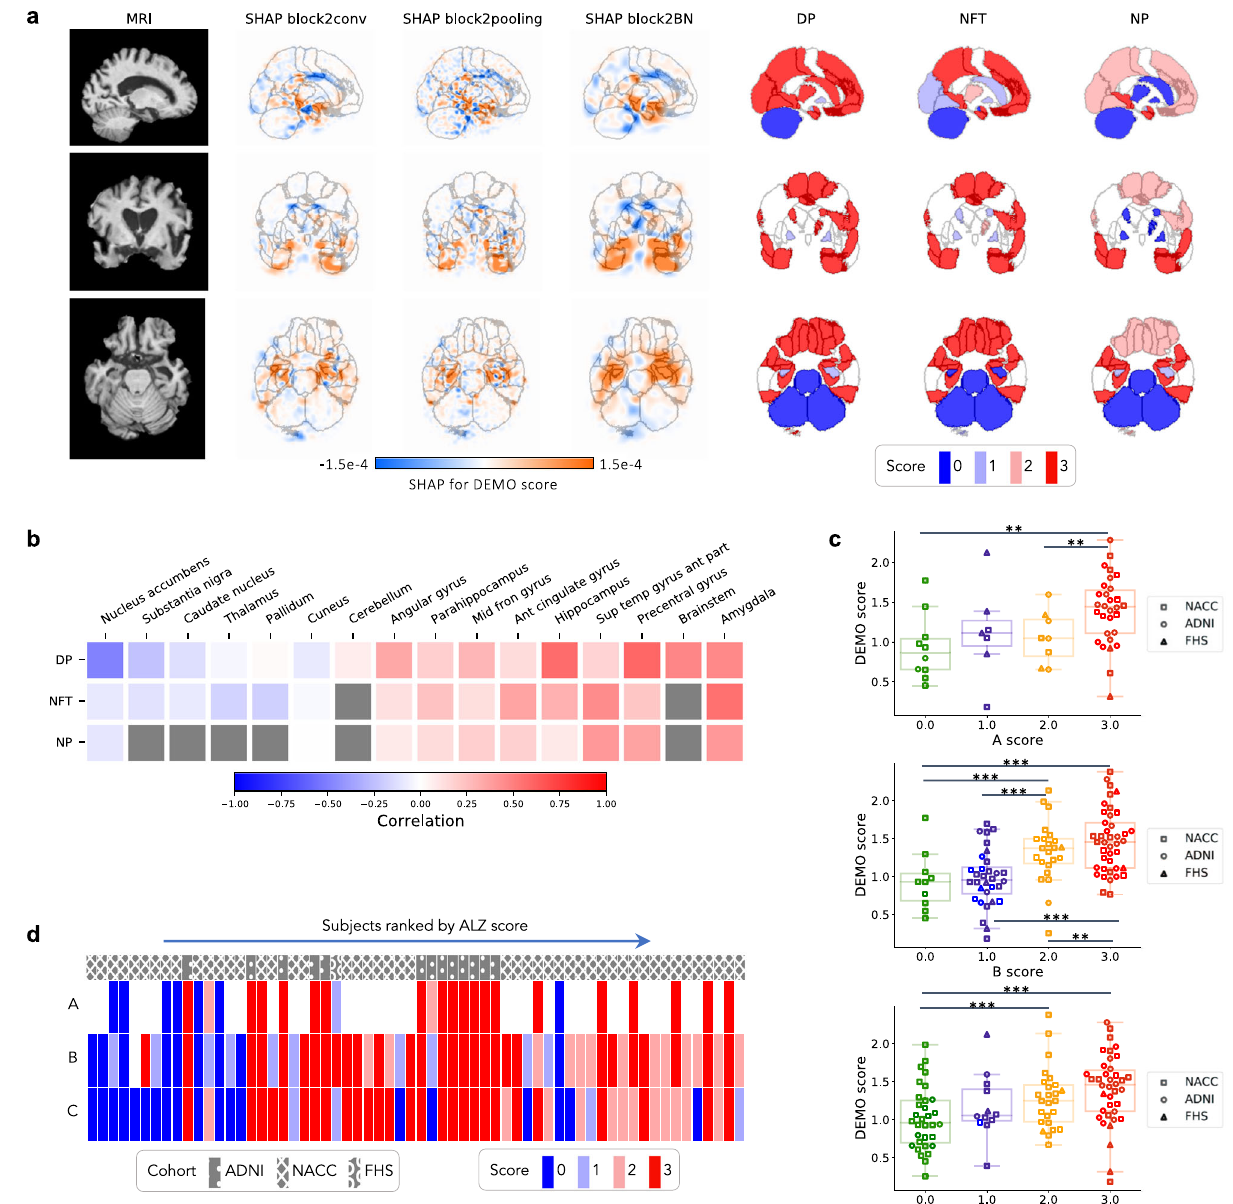
Fig. 5 Neuropathological validation. We correlated model fi ndings with regional ABC scores of neuropathologic severity obtained autopsied participants in NACC, ADNI, and FHS cohorts ( n = 110). a An example case from the Alzheimer ’ s Disease Neuroimaging Initiative (ADNI) dataset is displayed in sagittal, axial, and coronal views. The SHAP values derived from the second convolutional block and neuropathologic ABC scores are mapped to brain regions where they were measured at the time of autopsy. Visually, high concordance is observed between anatomically mapped SHAP values regardless of the hidden layer from which they are derived. Concordance is observed between the SHAP values and neuro fi brillary tangles (NFT) scores within the temporal lobe. b A heatmap is shown demonstrating Spearman correlations between population-averaged SHAP values from the input features of the second convolutional layer and stain-speci fi c ABC scores at various regions of the brain. A strong positive correlation is observed between the SHAP values and neuropathologic changes within several areas well-known to be affected in AD such as the hippocampus/parahippocampus, amygdala and temporal gyrus. c Beeswarm plots with overlying box-and-whisker diagrams are shown to denote the distribution of ABC system sub-scores (horizontal axis) versus model- predicted cognitive scores (vertical axis). The displayed data points represent a pooled set of participants from ADNI, NACC, and FHS for whom neuropathology reports were available from autopsy. Each symbol represents a study participant, boxes are centered at the median and extend over the interquartile range (IQR), while bottom and top whiskers represent 1st and 3rd quartiles − / + 1.5 x IQR, respectively. We denote p < 0.05 as *; p < 0.001 as **, and p < 0.0001 as *** based on post-hoc Tukey testing. d A heatmap demonstrating the distribution of neuropathology scores versus model predicted AD probabilities. Herein, each column within the map represents a unique individual whose position along the horizontal axis is a descending function of AD risk according to the deep learning model. The overlying hatching pattern represents the dataset (ADNI, NACC, and FHS), from which everyone is drawn. Source data are provided as a Source Data fi